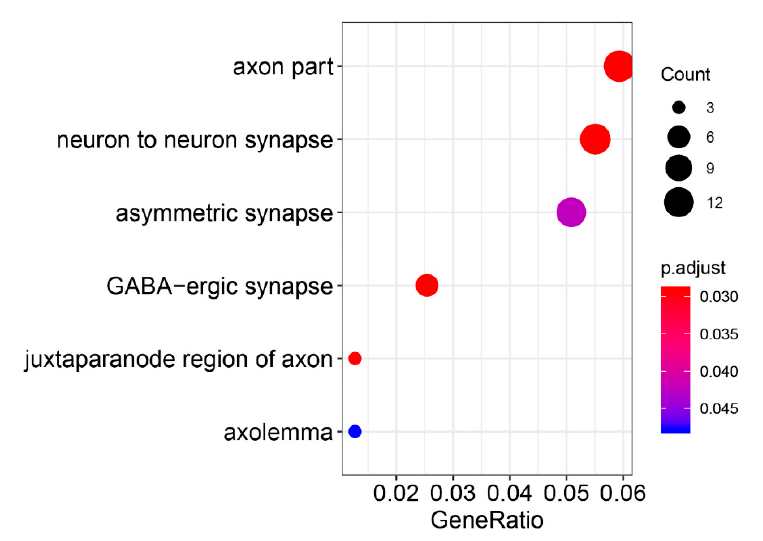
Figure 2. Gene Ontology enrichment of meta-analysis GWAS results. Table 1. Summary of risk genes identified by the summary data-based Mendelian randomization (SMR) and heterogeneity in dependent instruments (HEIDI) methods for